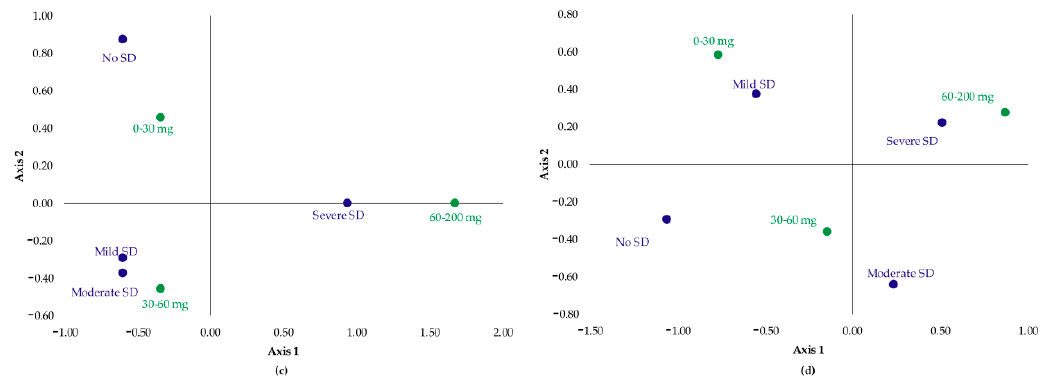
Figure A2. CFA graphical representations of the categories of two qualitative variables: ( a ) Tolerance to MTD (red) vs severity of SD (blue) of patients that only use MTD; ( b ) tolerance to MTD (red) vs severity of SD (blue) of patients that use MTD and benzodiazepines; ( c ) dose of MTD (green) vs severity of SD (blue) of patients that only use MTD; ( d ) dose of MTD (green) vs severity of SD (blue) that use MTD and benzodiazepines.